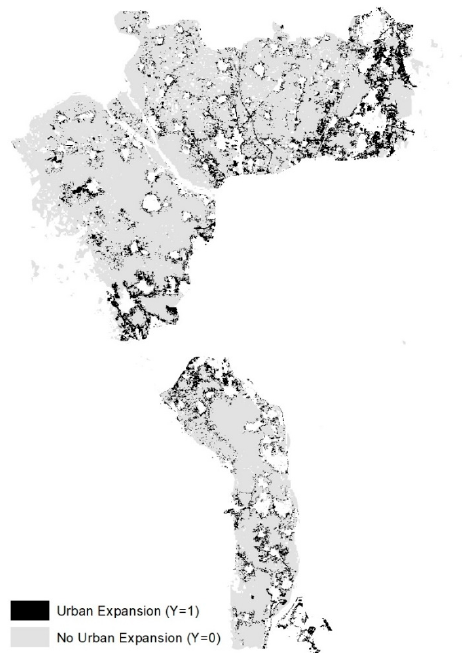
Figure 2. Dependent variable (Y): the change to urban area from 2007 to 2017.